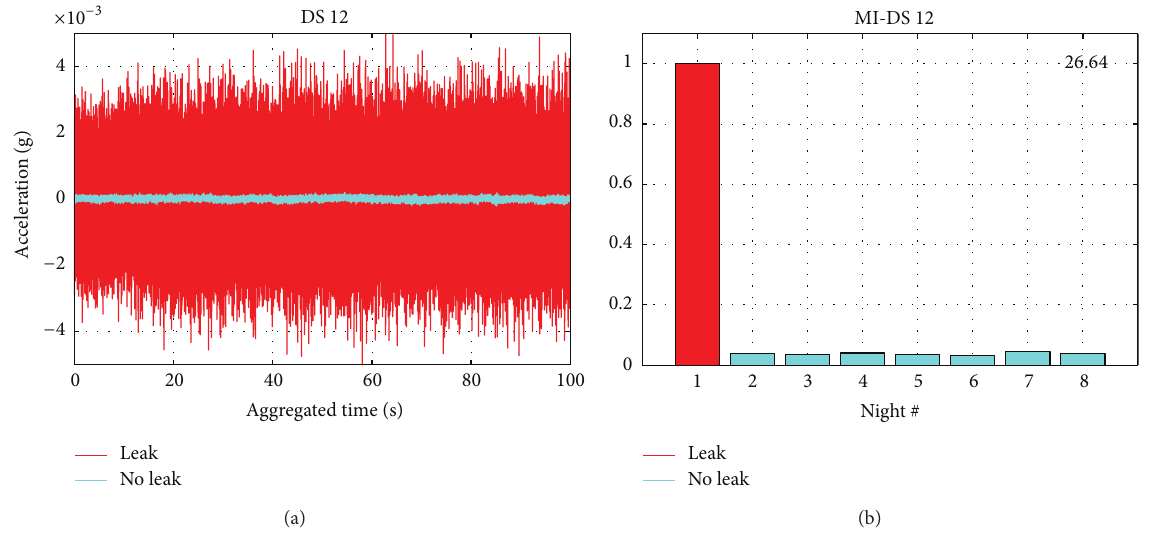
Figure 5: (a) Aggregated time histories and (b) computed MI values of raw signals from dataset DS